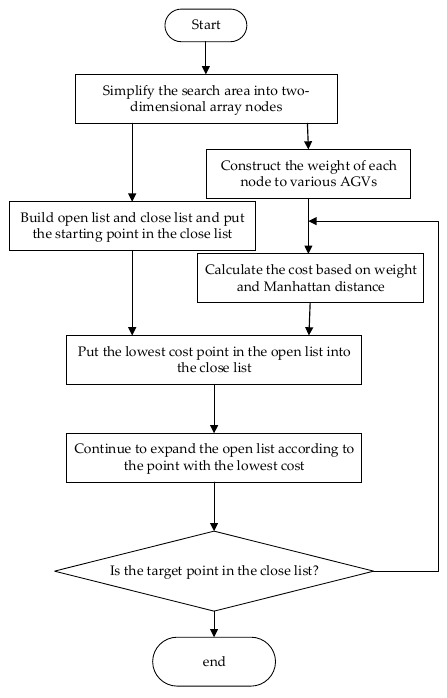
Figure 4. Improved A* algorithm flow chart.